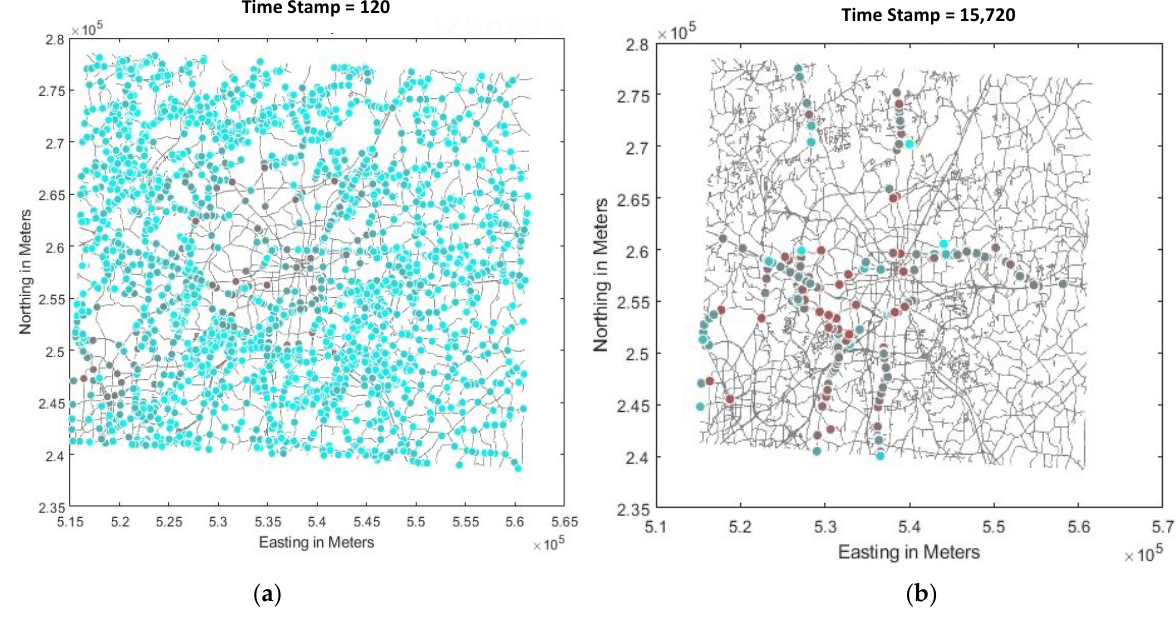
Figure 12. Snapshot of the movie at ( a ) t = 120 s and ( b ) t = 15,720 s. Colored circle indicates traffic at the intersection. The heavier the traffic, the darker the color. A dark brown circle means that the traffic at that intersection is very